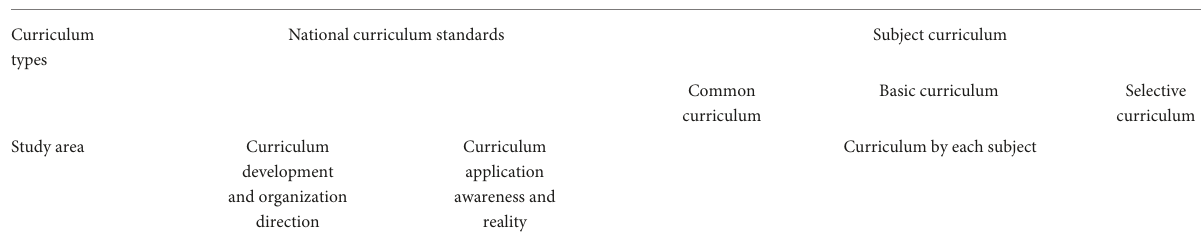
TABLE 1 Research analysis framework.